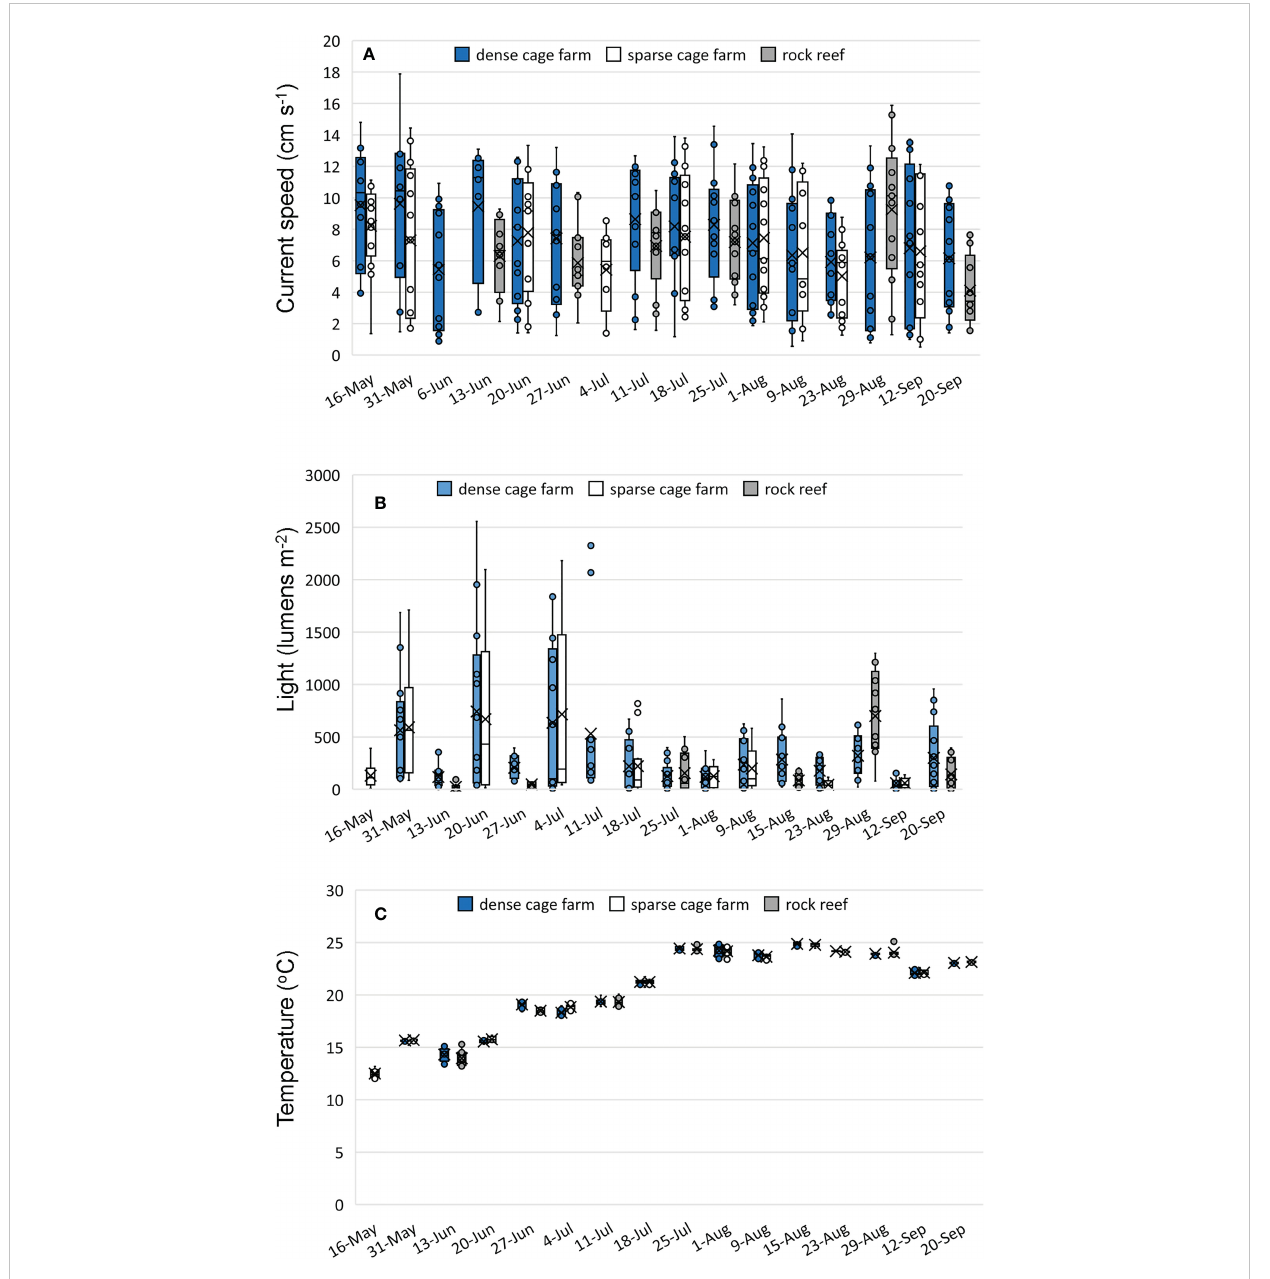
FIGURE 5 Environmental conditions at the dense cage farm, sparse cage farm, and rock reef sites in 2018. Mean current speed, light, and temperature were generated for each hourly interval during which cameras were recording. Boxplots indicate 25%, 50%, and 75% quartiles of the 13 hourly intervals on each date, mean is indicated by the ‘ x ’ symbol, and whiskers are set to 1.5 times the interquartile range. (A) current speed (cm s -1 ), (B) light (lumens m -2 ), (C) temperature (°C).